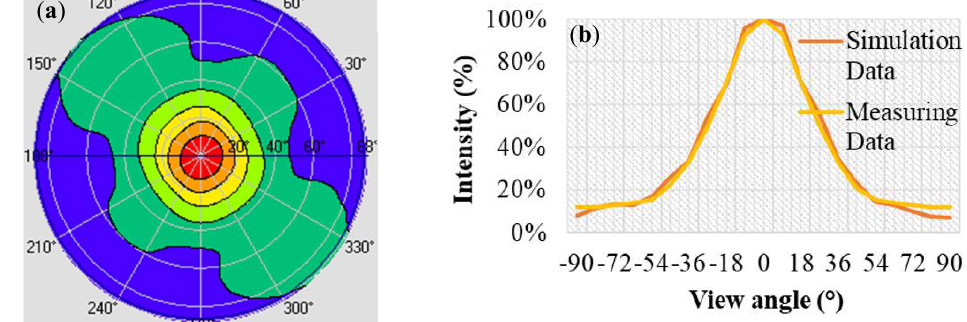
Figure 19. Light distribution of extra-thin, large-area, high-luminance surface light source module: ( a ) light polar diagram of measured data; ( b ) comparison of light distribution curves of the simulation and measurement results.